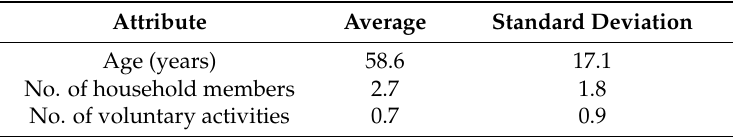
Table 3. Average values for personal demographic attributes.